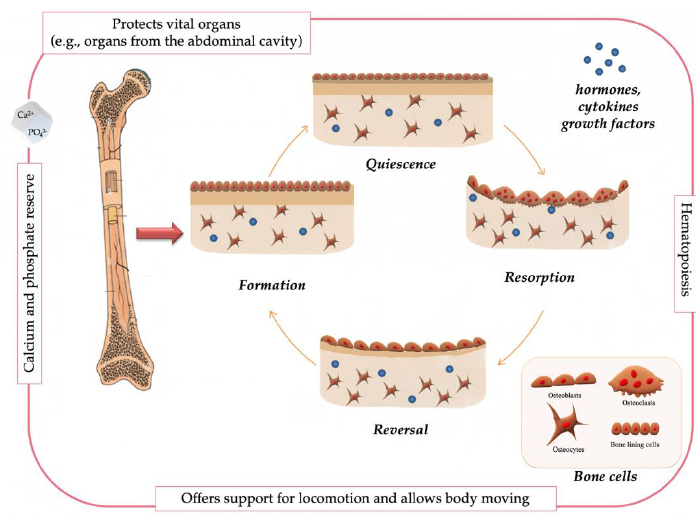
Figure 1. Bone main functions and bone remodeling process.